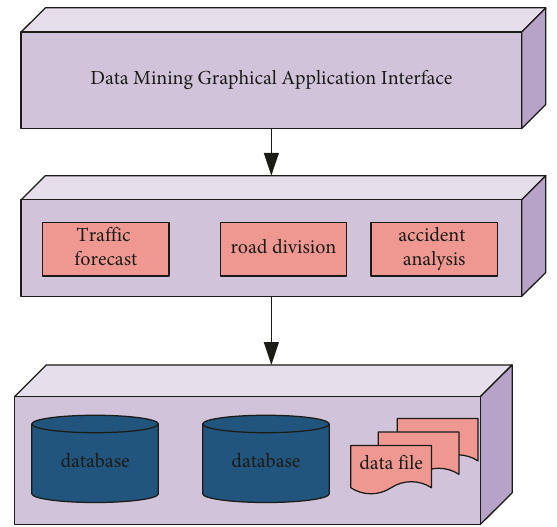
Figure 4: Architecture of intelligent transportation data mining application platform.